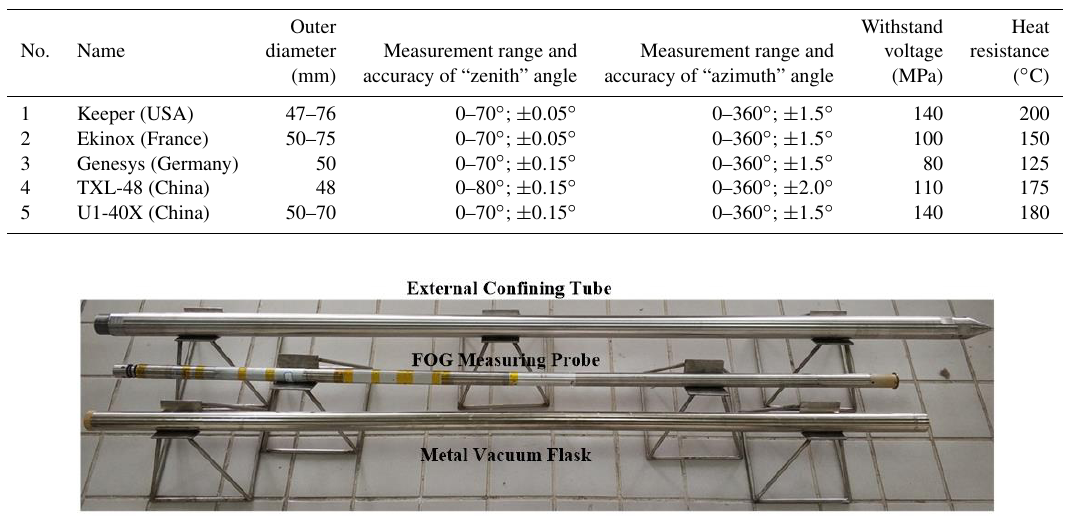
Figure 2. Photos of external confining tube, metal vacuum flask, and FOG measurement